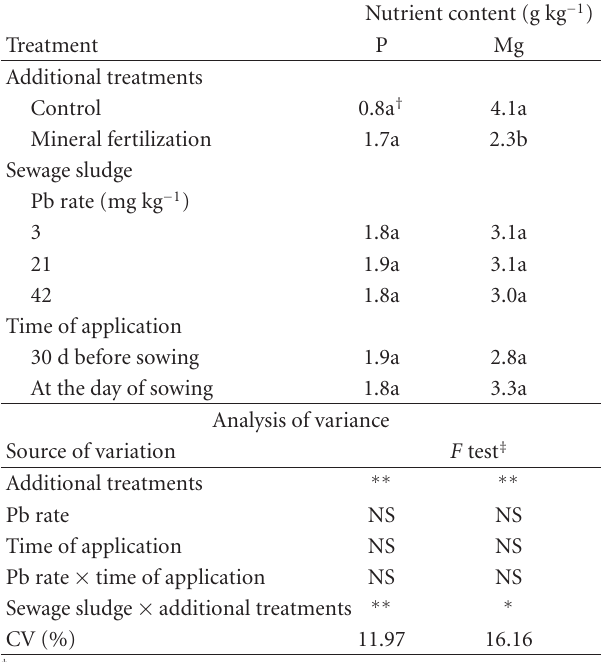
Table 5: Phosphorus and Mg contents in peanut shoot as a function of Pb rates applied to soil with sewage sludge, time of sewage sludge application, mineral fertilization, and